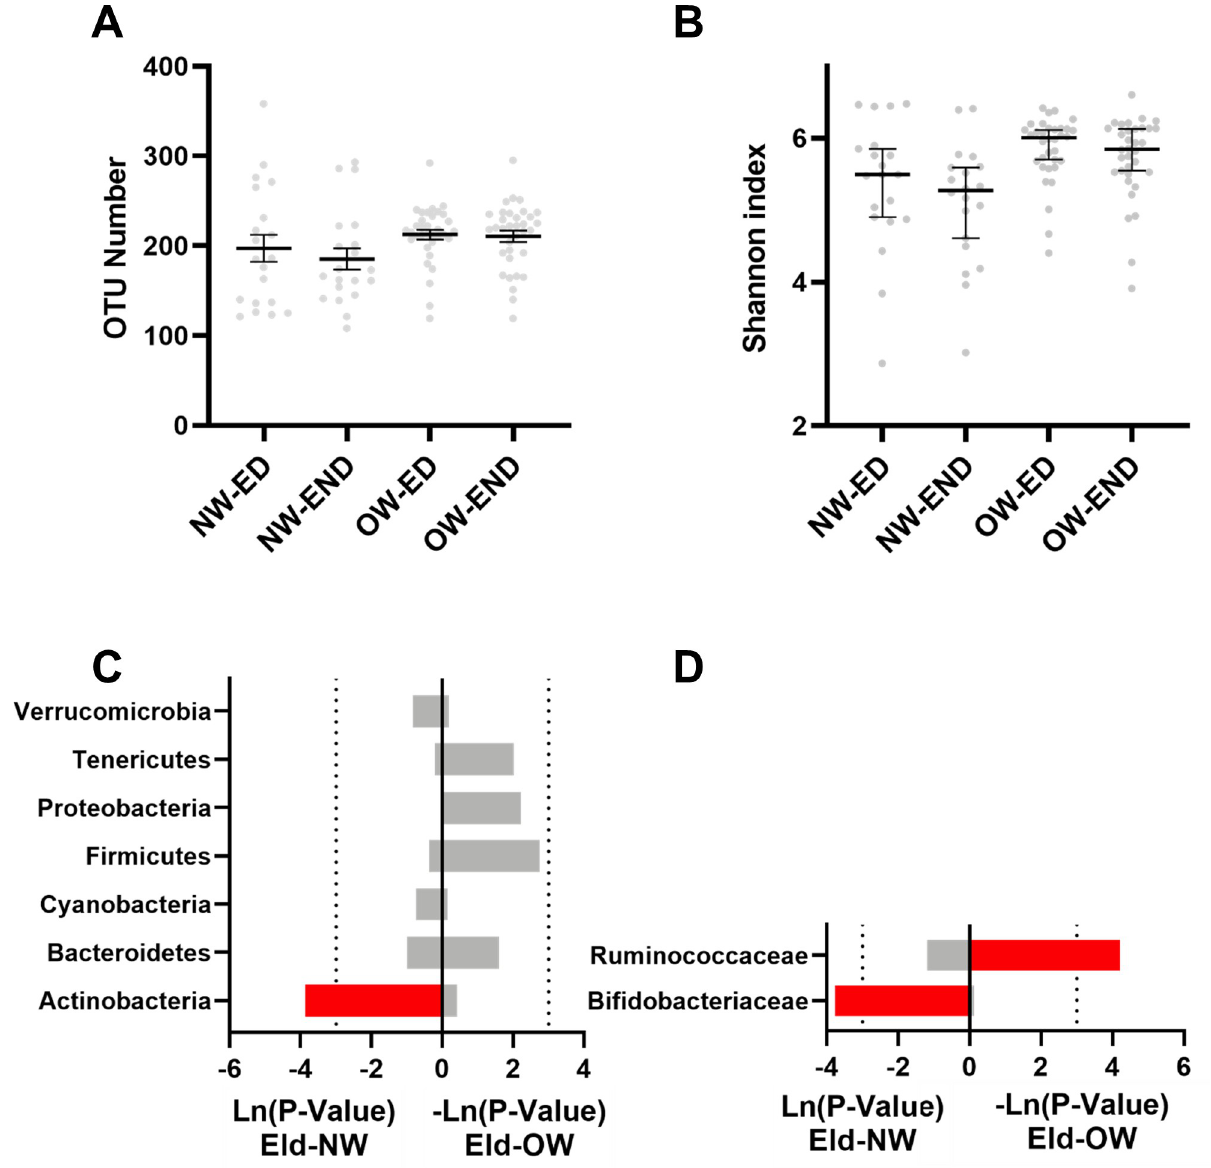
Fig 3. The effect of dog ownership on the microbial composition of female and male elderly individuals. Dog ownership did not affect the (A) number of OTUs or the (B) Shannon index. The effect of dog ownership on bacteria at the (C) phylum level and (D) family level. The red bar represents a significant increase, while the blue bar represents a significant